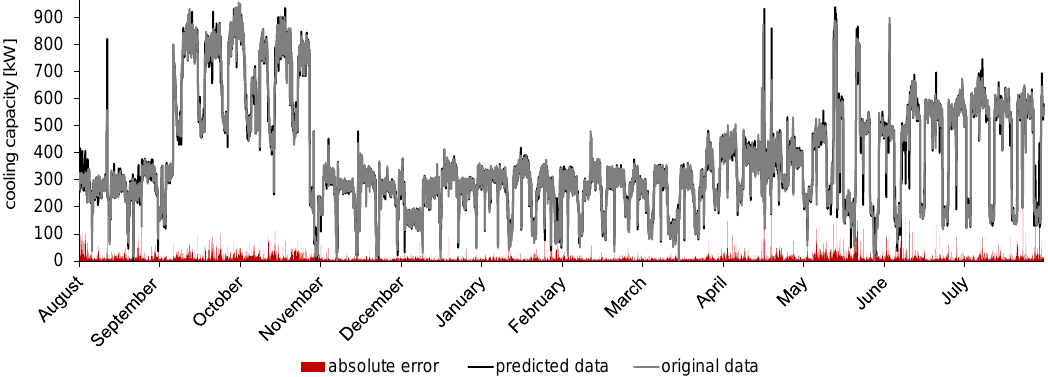
Figure 16. Time series plot of original and predicted cooling capacity and resulting error predicted with polynomial regression (PR) algorithm.